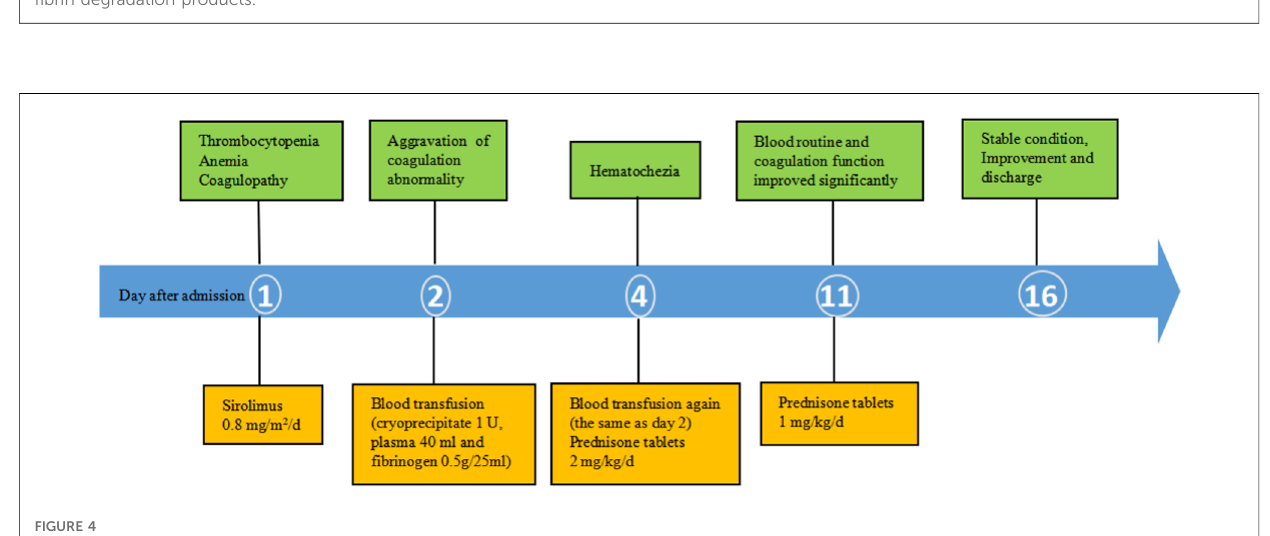
FIGURE 3 Time course of the main results of laboratory examinations and treatment. Thrombocytopenia, anemia and coagulopathy improved with treatment (arrow, transfusion). Plt, Platelets; Hb, Hemoglobin; Fib, fi brinogen concentration; PT, prothrombin time; APTT, activated partial thrombin time; FDP, fi brin degradation